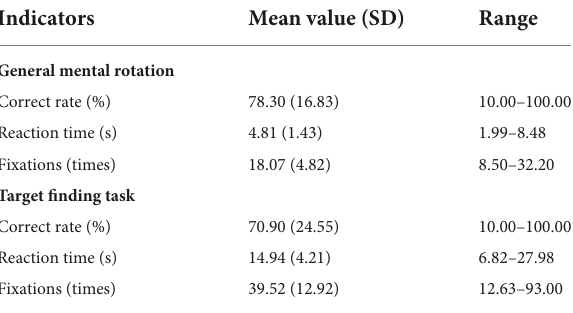
TABLE 2 The spatial cognition ability of the cohort based on eye-tracking